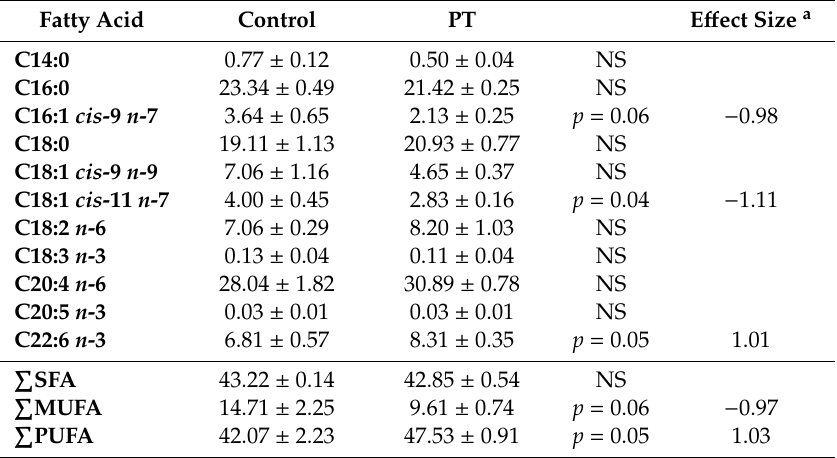
Table 4. Fatty acid profile (% of total hepatic phospholipids) of the hepatic phospholipids from obese Zucker rats treated or not with pterostilbene (30 mg / kg body weight / day for six weeks). Fatty